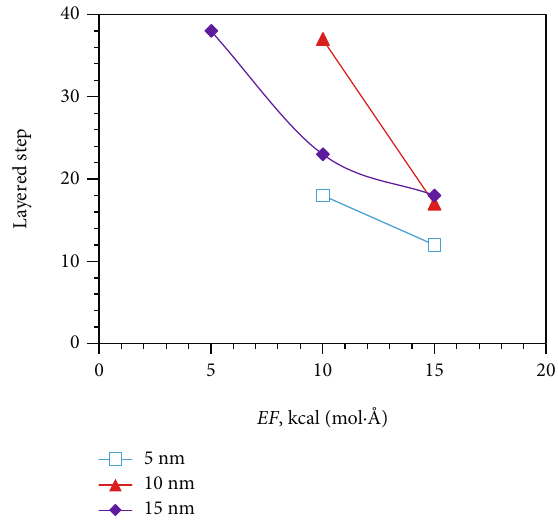
Figure 5: The beginning step of strati fi cation of models 1 –